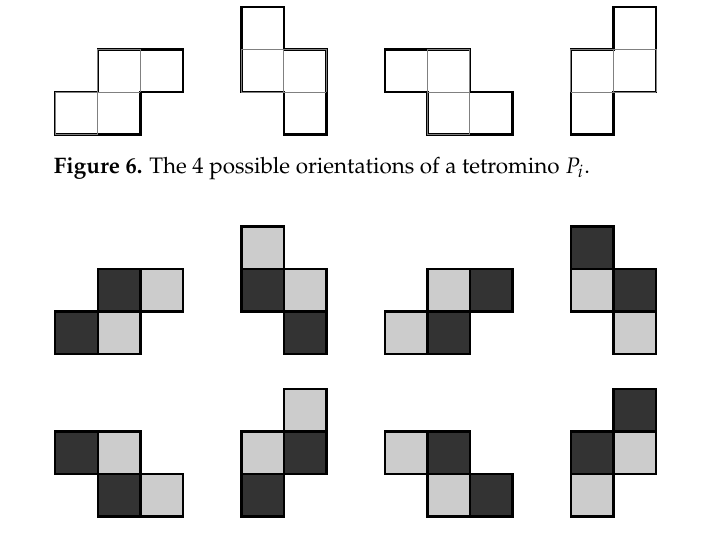
Figure 7. The 8 possible orientations of the pariomino P + of Figure 6.